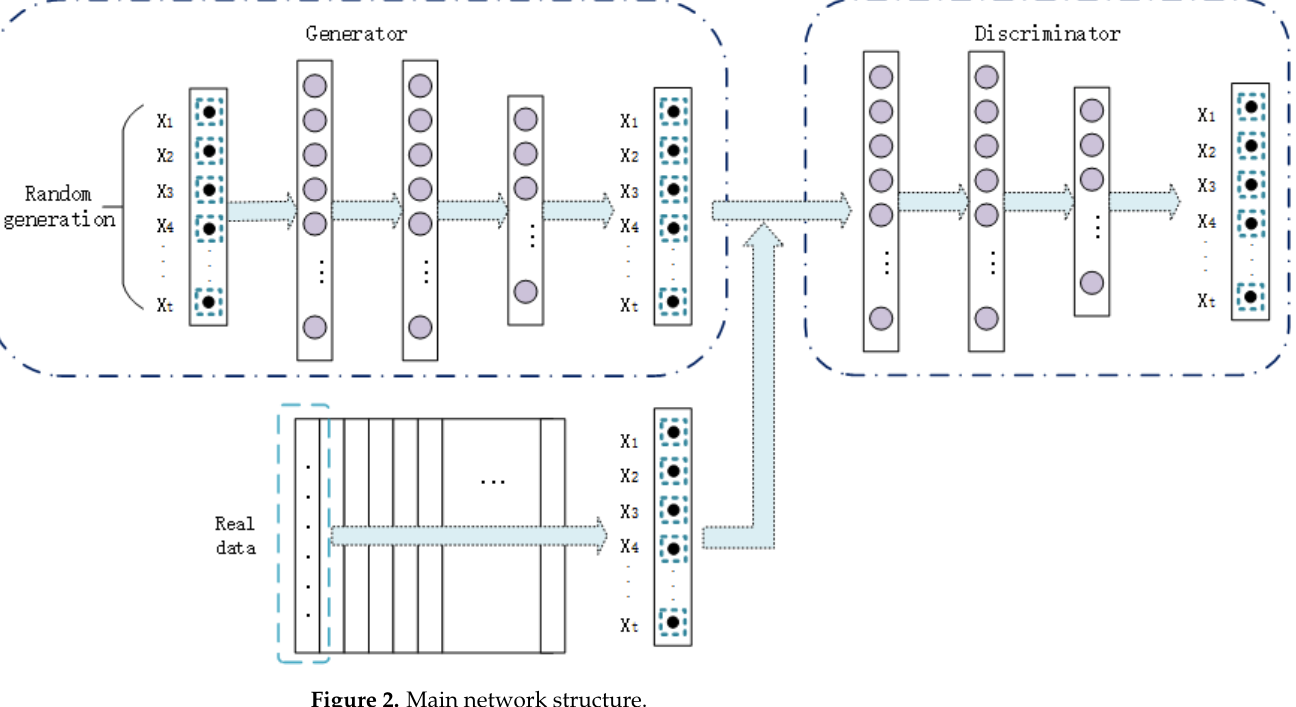
Figure 2. Main network